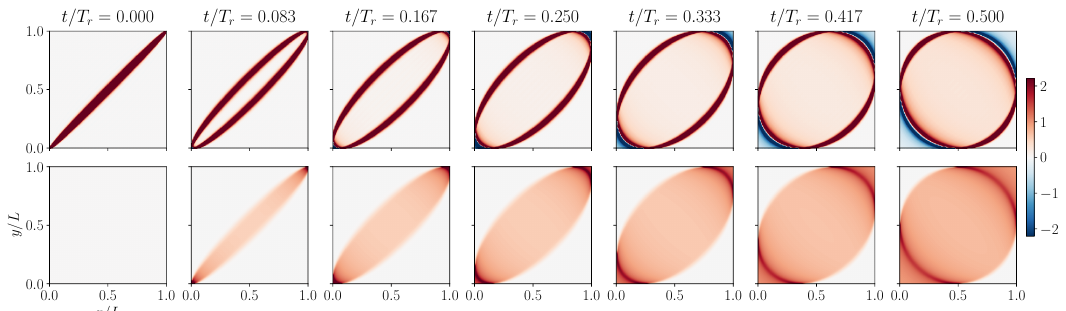
Figure 18: Same as Fig. 17 but for a homogeneous box with Dirichlet boundary conditions.